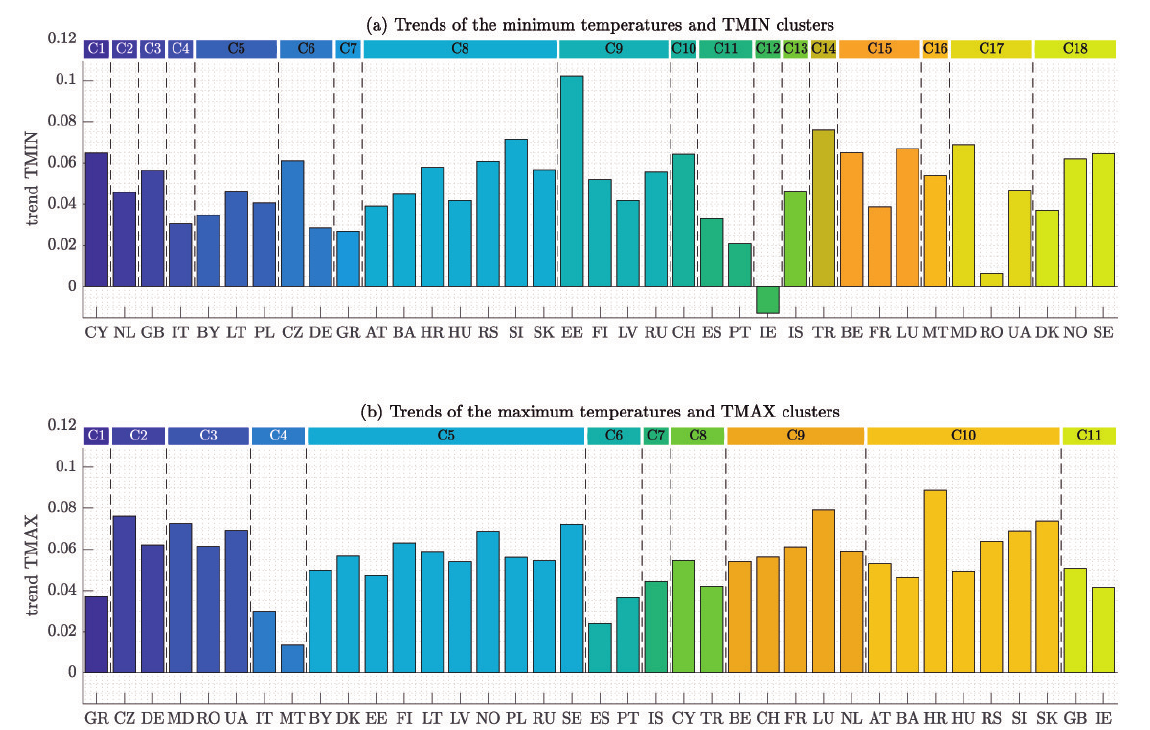
Figure 12. Trend determined by the GAM for the ( a ) minimum and ( b ) maximum temperatures of the 37 countries. The colors indicate the cluster to which each country belongs according to Figure 7.